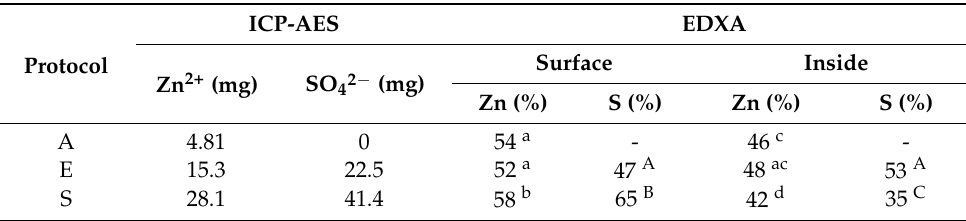
Table 3. Zinc (Zn 2+ ) and sulfate (SO 42 − ) content and distribution in the matrices processed by the different protocols. Different letters mean significant